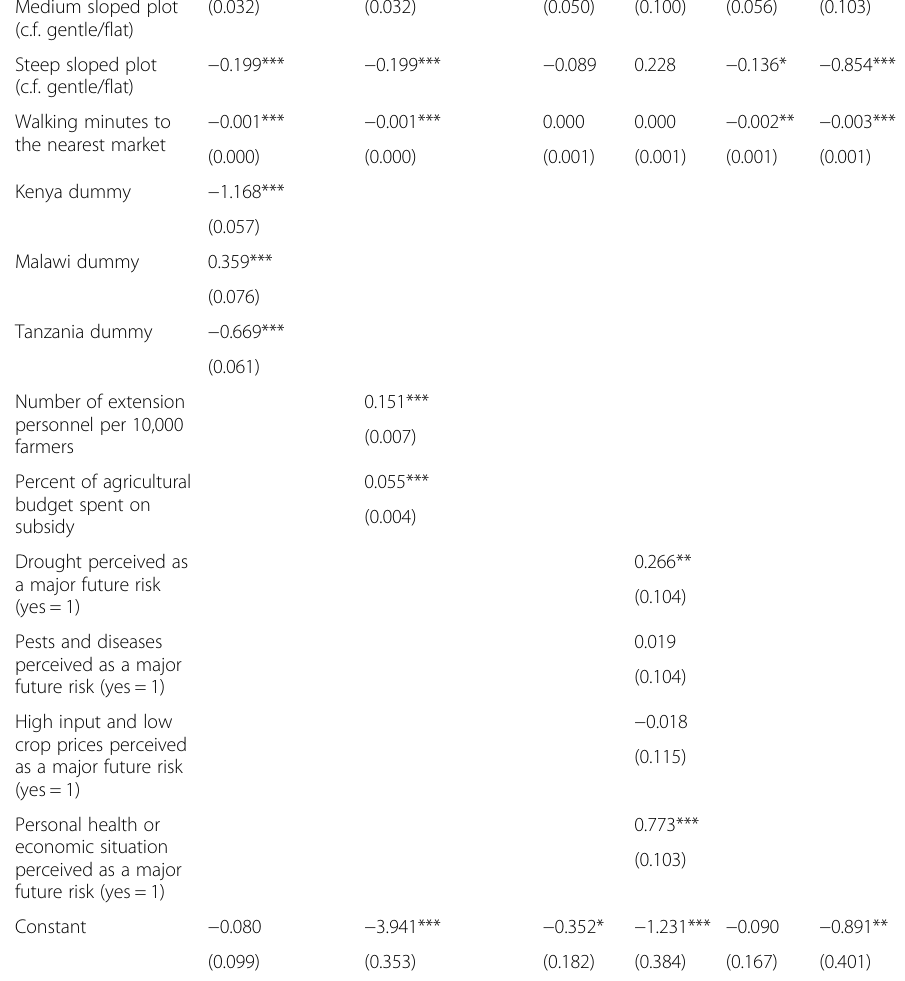
Table 3 Probit estimation of factors that affect plot level adoption of minimum tillage in Ethiopia, Kenya, Malawi and Tanzania (Continued) Medium sloped plot (c.f. gentle/flat)